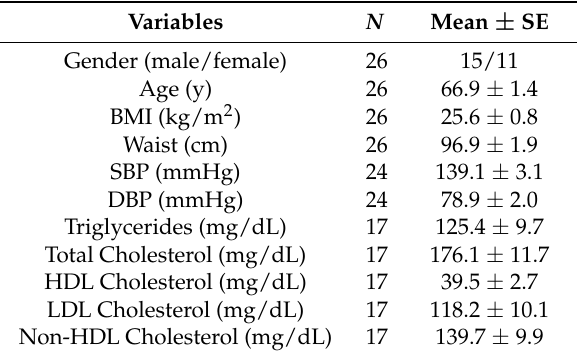
Table 1. General characteristics of studied population.